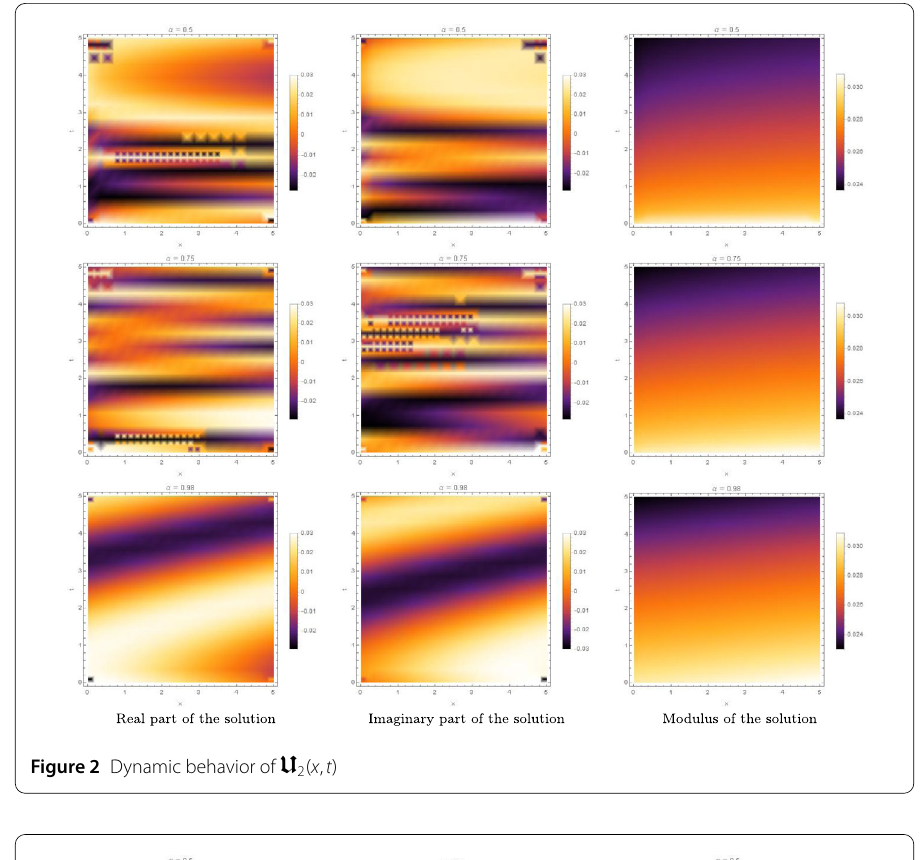
Figure 2 Dynamic behavior of U 2 ( x , t )